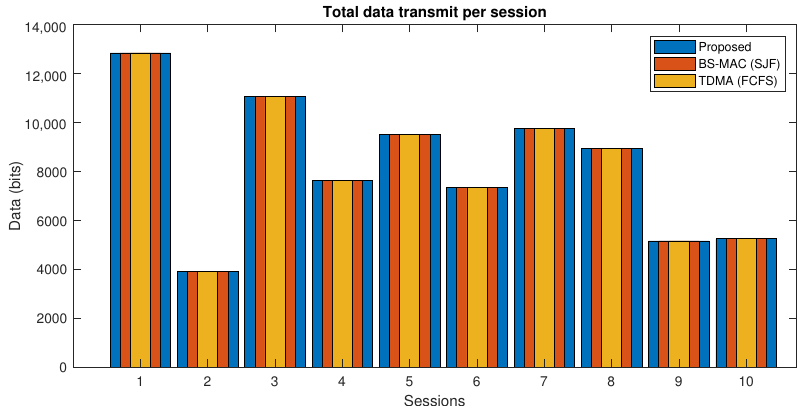
Figure 8. Data transmission in each session (Case I).